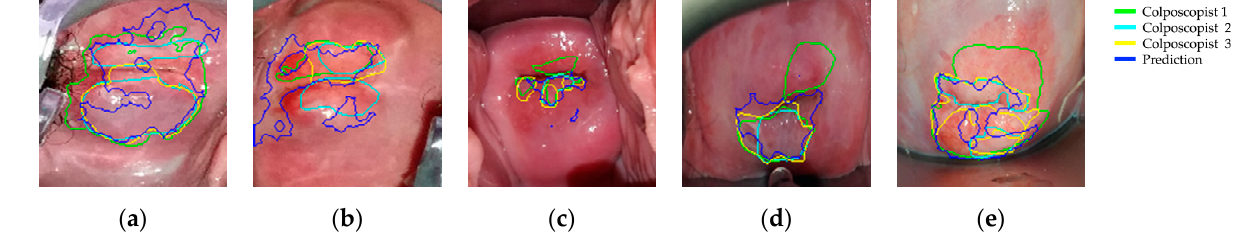
Figure 8. Colposcopists’ annotations and algorithm’s predicted labels drawn in one-minute frames.